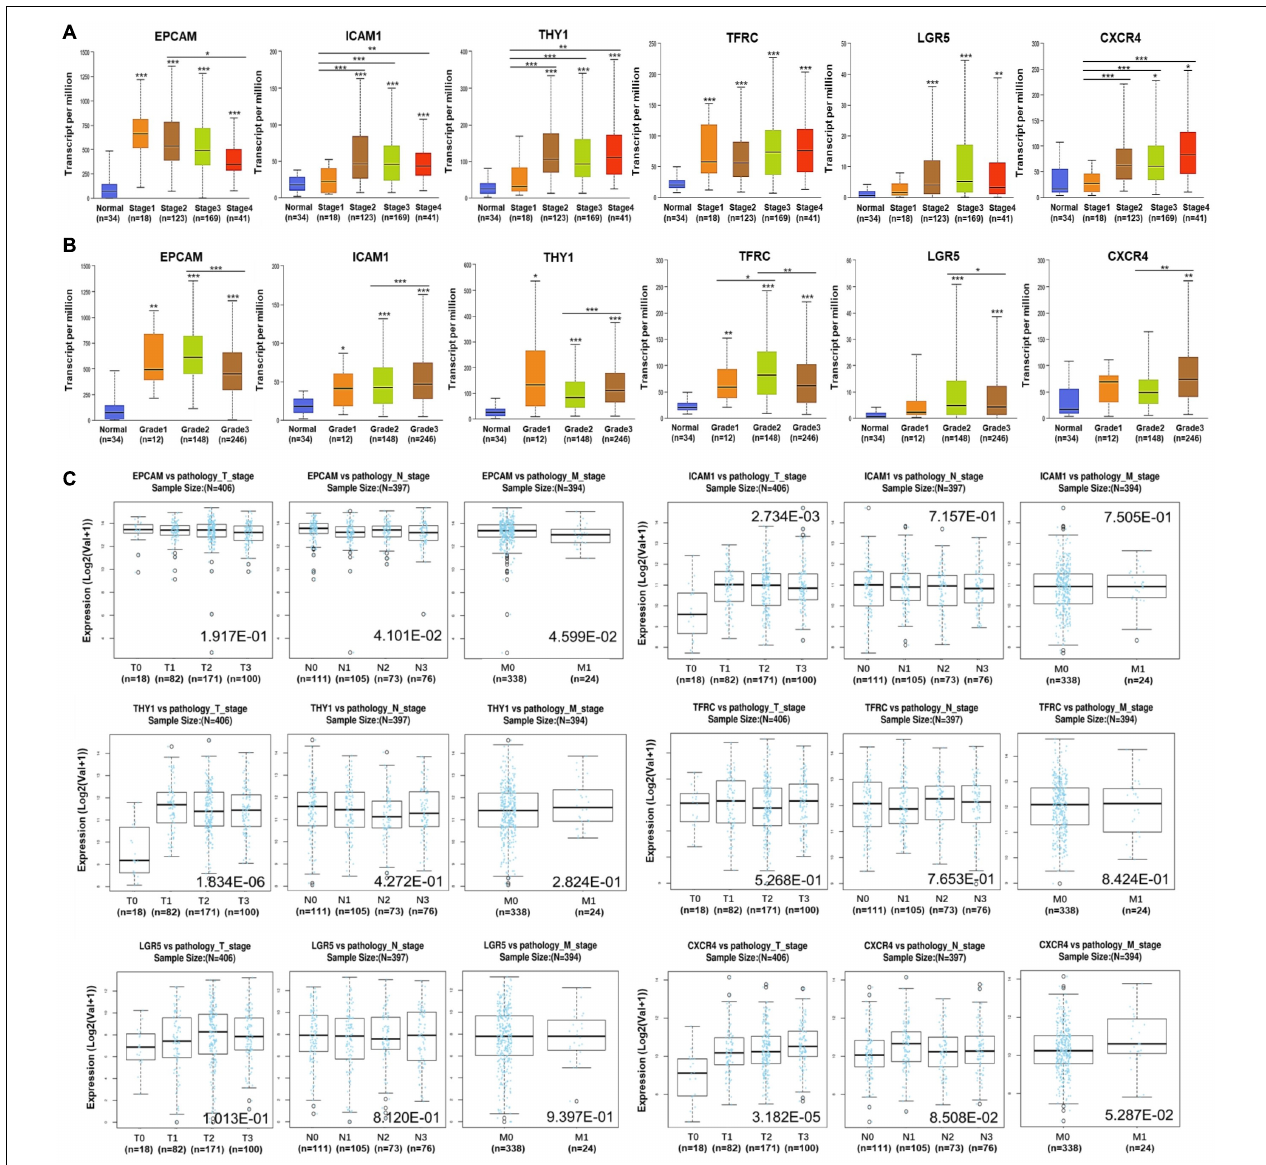
FIGURE 2 | Expression of GCSC markers in GC patients with distinct clinicopathological parameters. Expression of GCSC markers in GC patients with diverse (A) pathological stages, (B) tumor grades, and (C) pathological TNM stages. The box plots and P- values in graphs A and B were from UALCAN, while those in graph C were from LinkedOmics; * P < 0.05, ** P < 0.01, *** P < 0.001.